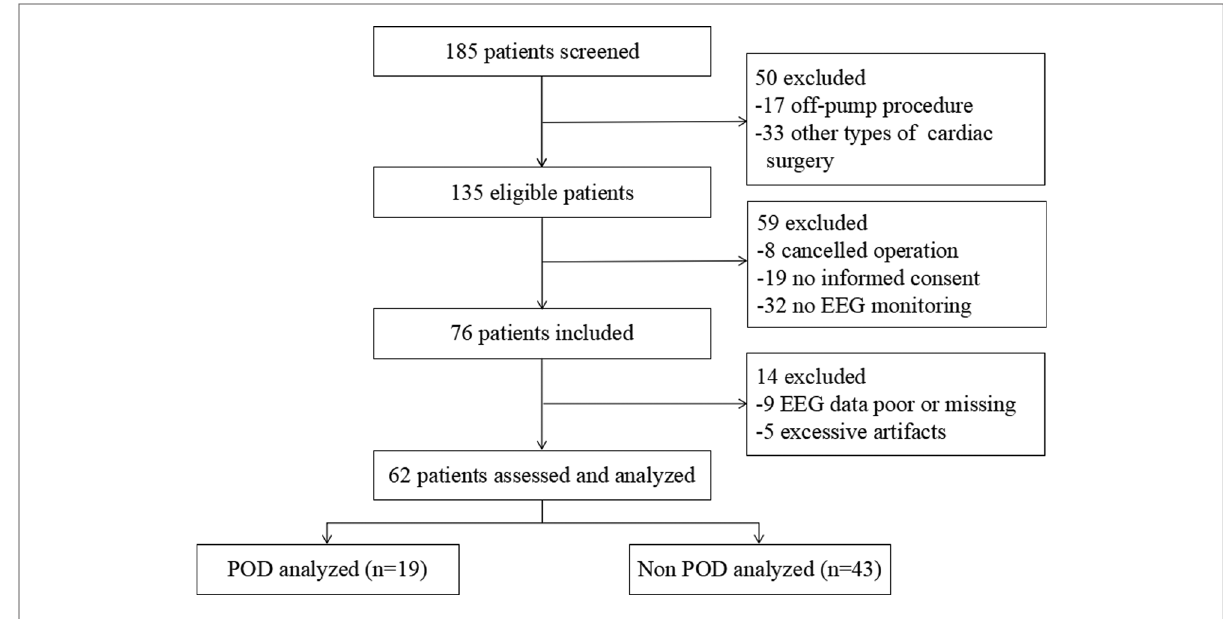
FIGURE 1 Flow diagram demonstrating the process of patient enrollment. POD, postoperative delirium; EEG,